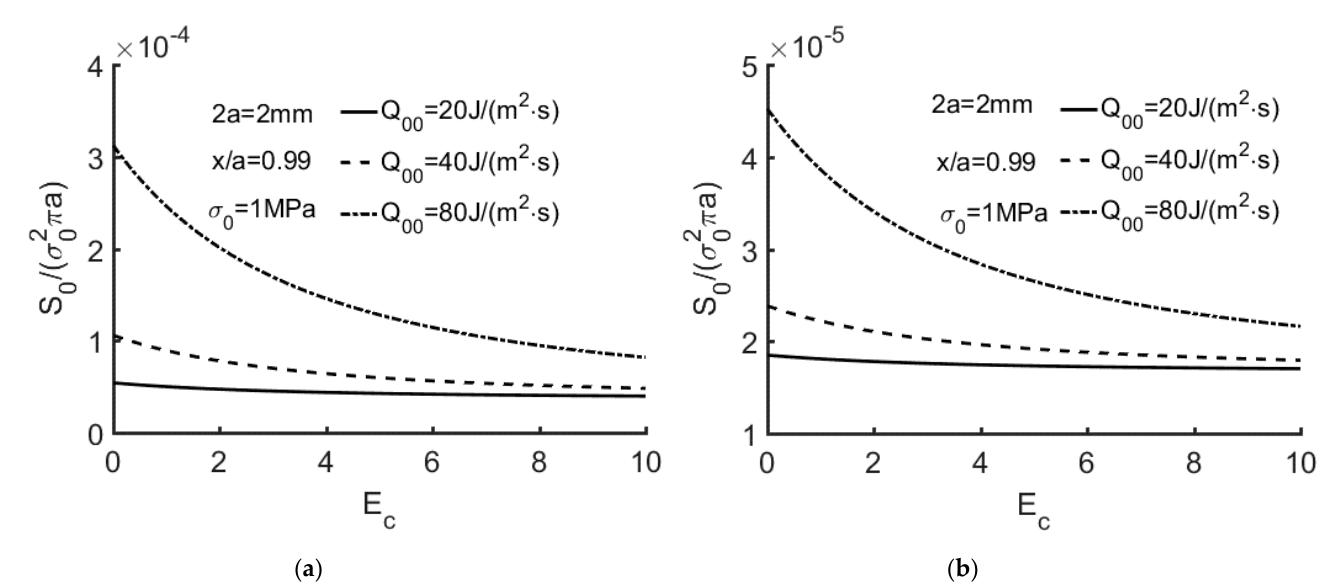
ε = 0.01. ( 2a = 2 mm , x/a = 0.99, σ 0 = 2 MPa). The ε = 0.01 (2 a =2 mm, x/a =